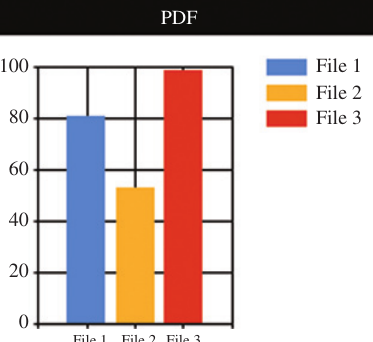
Figure 7. PDF Chart in 2D Bar